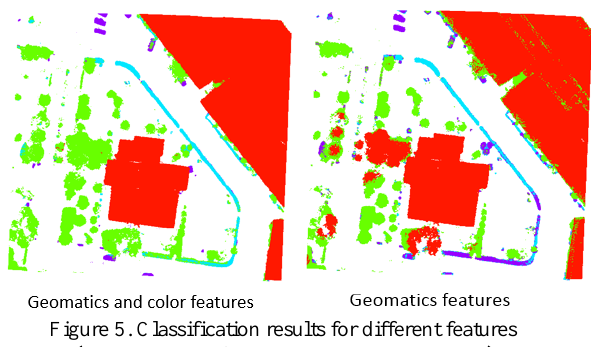
Figure 5. Classification results for different features